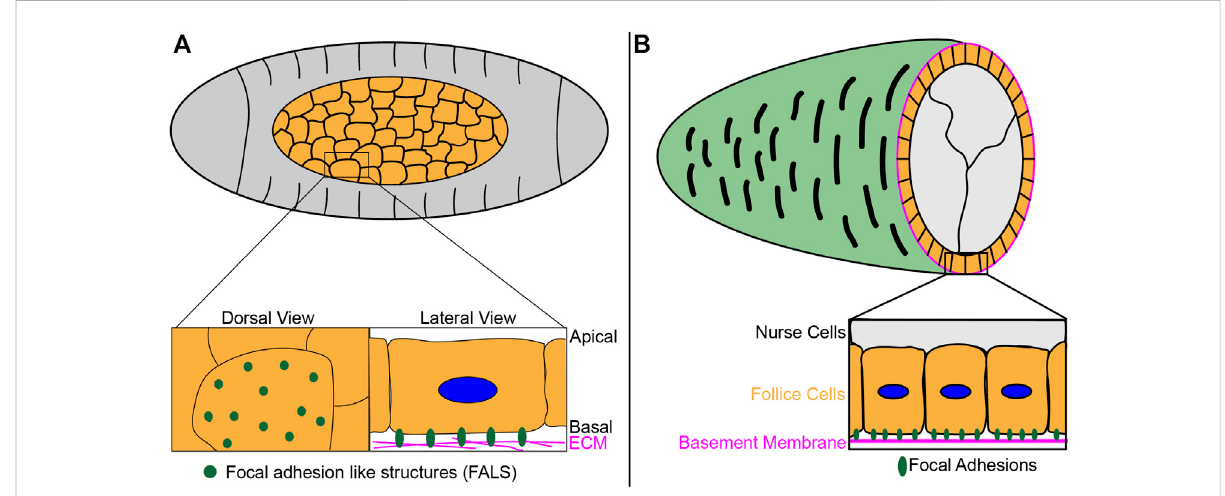
FIGURE 3 Drosophila developmental processes utilize adhesion structures for collective cell migration. (A) During Drosophila dorsal closure, focal adhesionlikesructures (FALS)formatcontactsitesbetweentheamnioserosa(orange)andtheunderlying ECM,asepidermalcells(gray)migrateasa sheet and seal on the dorsal side. These structures are required to transmit the necessary tension generated for dorsal closure. For a live imaging example of this process, please reference (Goodwin et al., 2016). (B) As follicle cells (orange) collectively migrate during Drosophila egg chamber elongation, cells form focal adhesions at contact sites with the underlying ECM-rich basement membrane. For a live imaging example of this process, please reference (Lewellyn et al.,